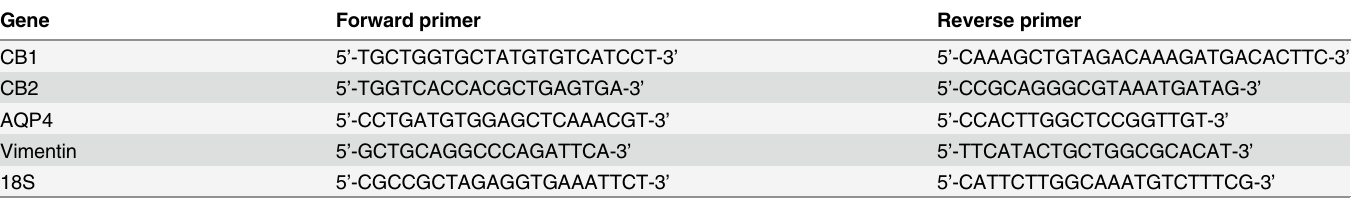
Table 2. Primer sequences for quantitative real-time polymerase chain reaction.